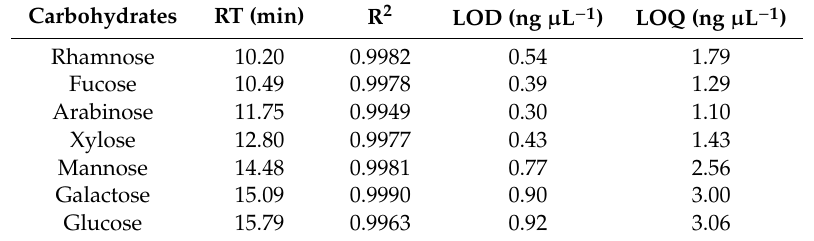
Table 3. Sensitivity and linearity of GC–MS quantification method for hemicellulose